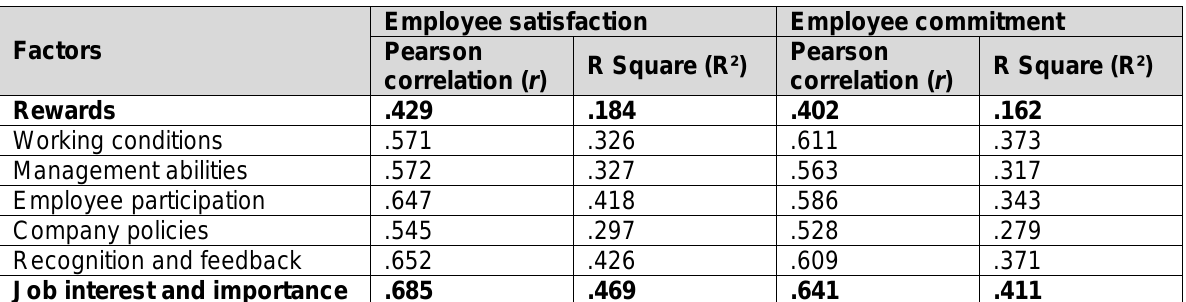
Table 5: Motivational factors in relation to employee satisfaction and employee commitment – Pearson correlation coefficients and linear regression